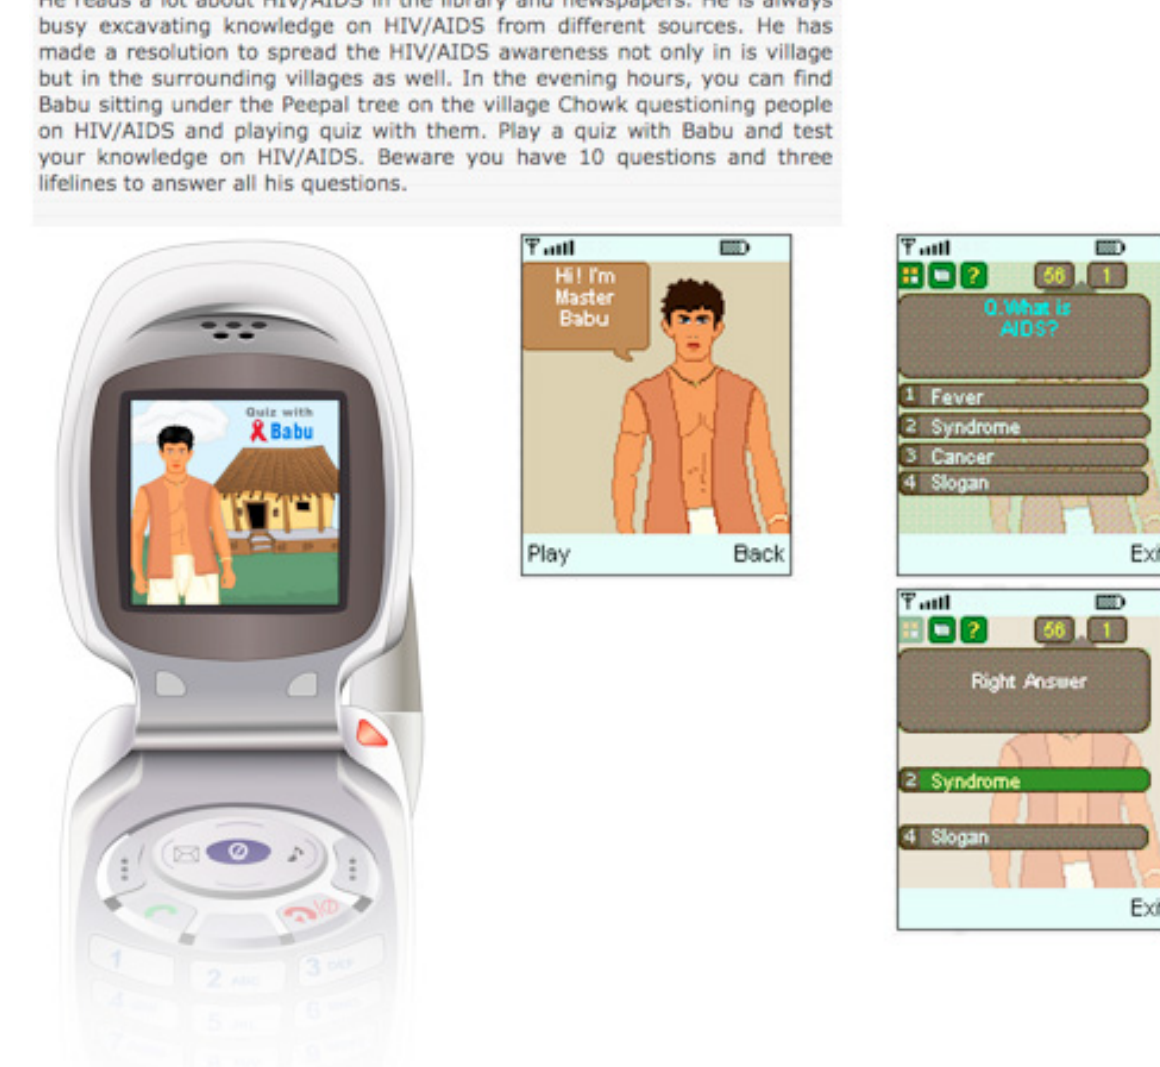
Figure 2. Freedom HIV/AIDS game: Quiz with Babu. Reproduced with permission